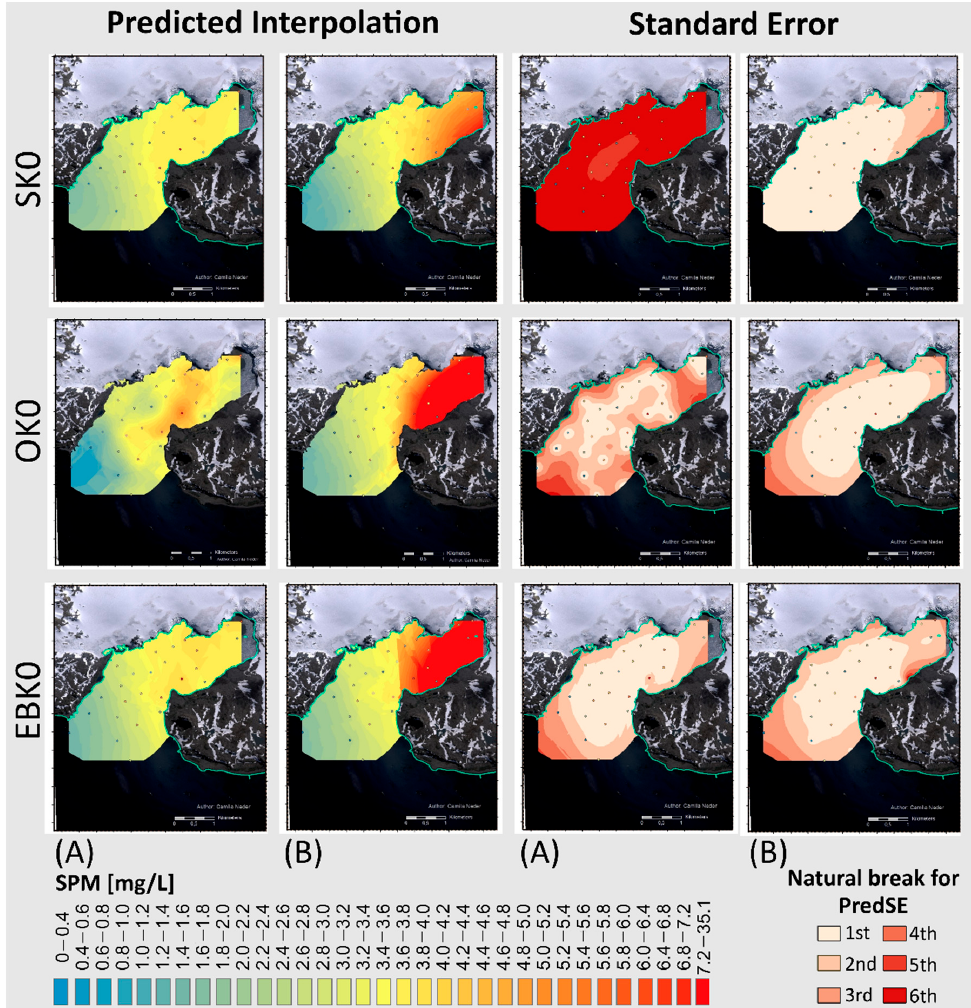
Figure 6. Six default geostatistical models . ( Left ): data distribution and interpolation results for SPM in Potter Cove for 09/02/2011 without ( A ) and including meltwater with SPM input by meltwater streams ( B ) using Simple Kriging (SK), Ordinary Kriging (OK), and Empirical Bayesian Kriging (EBK) models. ( Right ), ( A , B ): predicted standard error (PredSE) to reveal the scope of feasible interpolation area. Best models are determined automatically by the ArcGIS tool with a mean close to zero and a root mean squared standardized error close to one.